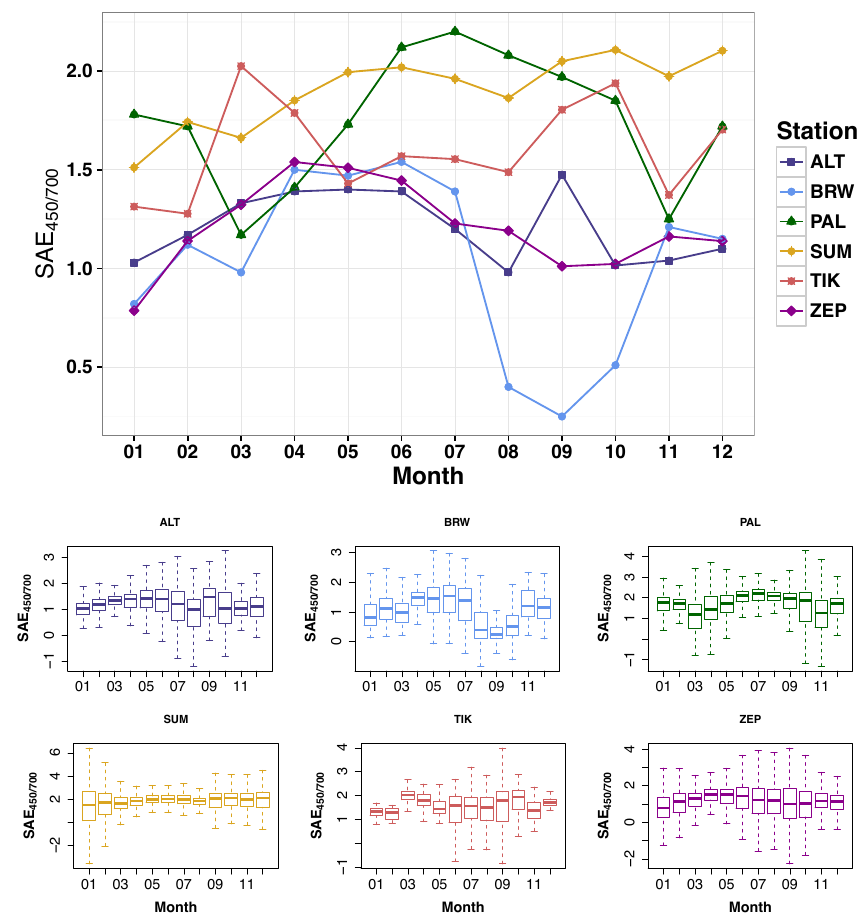
Figure 6. Seasonality of scattering Ångström exponent (SAE) at all sites. Large plot shows monthly medians of hourly average SAE at the 450 and 700nm wavelength pair at each station; subplots below show boxplots of SAE at individual sites, with horizontal line at the median, edges of the box at 25th and 75th percentiles, and whiskers at 5th and 95th percentiles. Note that y axes are different on each